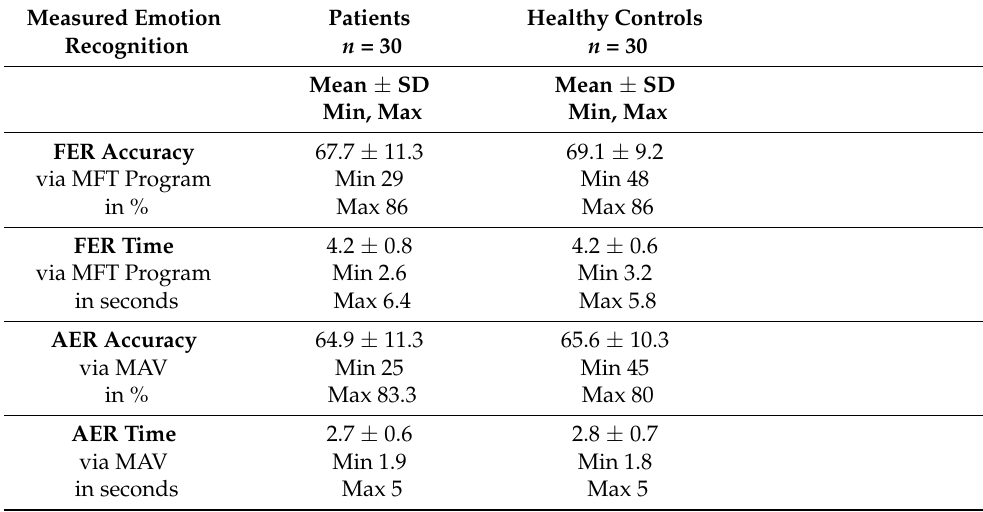
Table 1. Results of measured facial emotion recognition (FER)-accuracy/time, and auditory emotion recognition